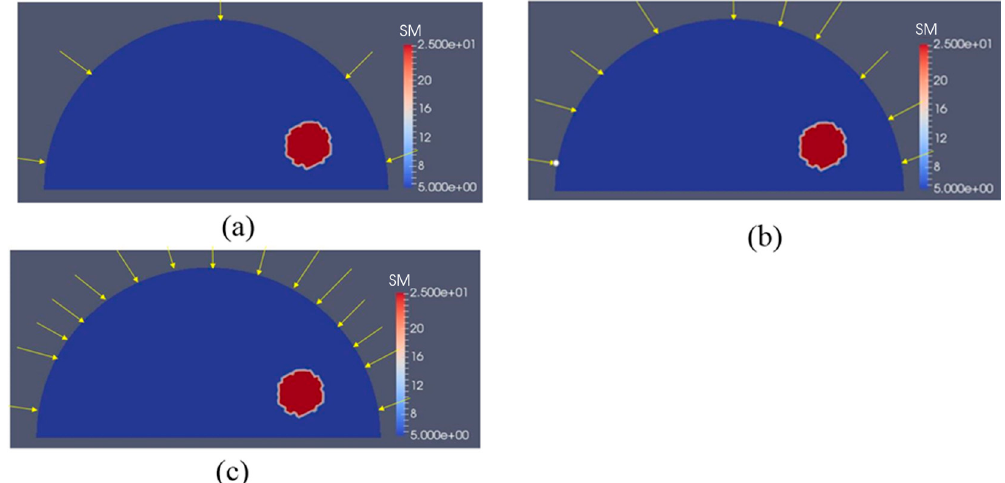
Figure 4. The problem domain for a semi-circle with a stiff inclusion surrounded by a soft background. The yellow arrows indicate the indentation locations, and measured boundary displacements are simulated on the top curve. ( a ) 5 arrows representing 5 sequentially applied forces to obtain boundary displacement data sets; ( b ) 10 arrows representing 10 sequentially applied forces to obtain boundary displacement data sets; and ( c ) 15 arrows representing 15 sequentially applied forces to obtain boundary displacement data sets (unit in the scale bar: kPa). Note: “SM” stands for shear modulus.